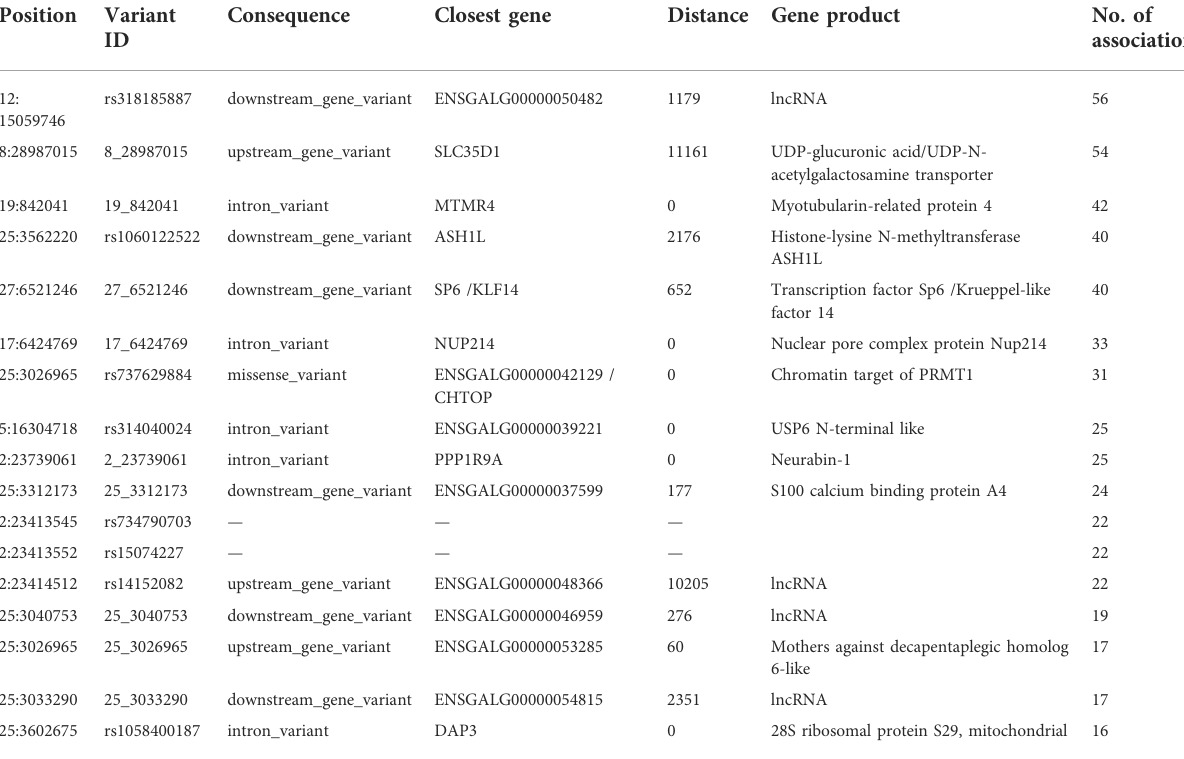
TABLE1Genomicvariantswitha p -value < 1×10 – 8 inmorethan15expressiongenomewideassociationstudies(eGWAS).Onlyonevariantpergeneis shown since they represent the respective associated haplotype block. Closest genes up to a distance of 100 kb were